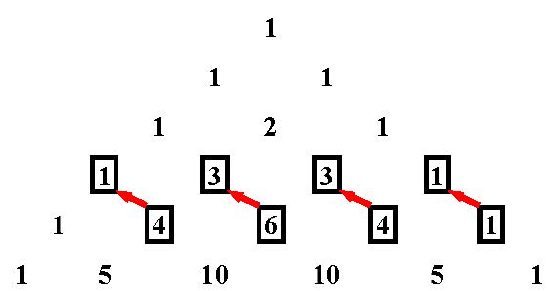
Figure 42: How to move from the element providing the total num- ber of m -faces of the 3 -simplex to the element providing the